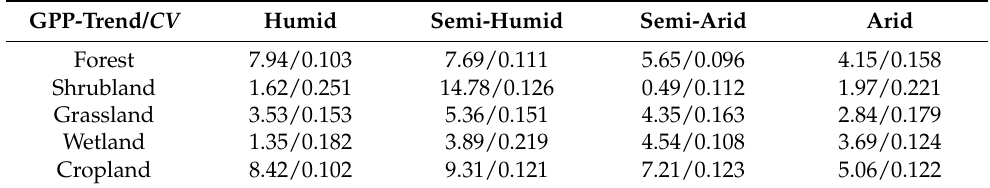
Table 1. Trends (units: gC · m − 2 · yr − 1 ) and CV of GPP for each vegetation type in different arid-humid zones from 2001 to 2021.